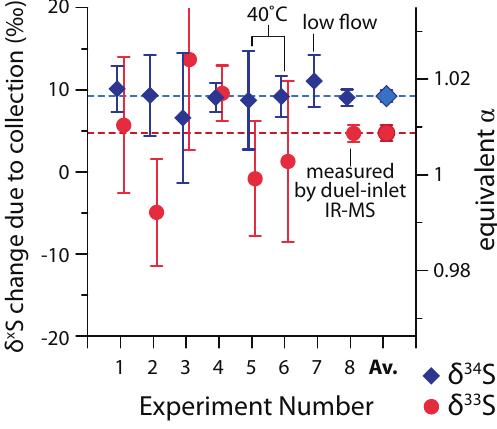
Fig. 6. Fractionation introduced during collection of SO 2 in H 2 O 2 solution. The duel-inlet IR-MS sample was measured as described in Ono et al. (2006). The shown data of experiments 1–7 are the weighted averages of individual NanoSIMS measurements, while the horizontal dashed lines and the two data points at the right side show the weighted averages of all experiments. Error bars are the 1 σ standard